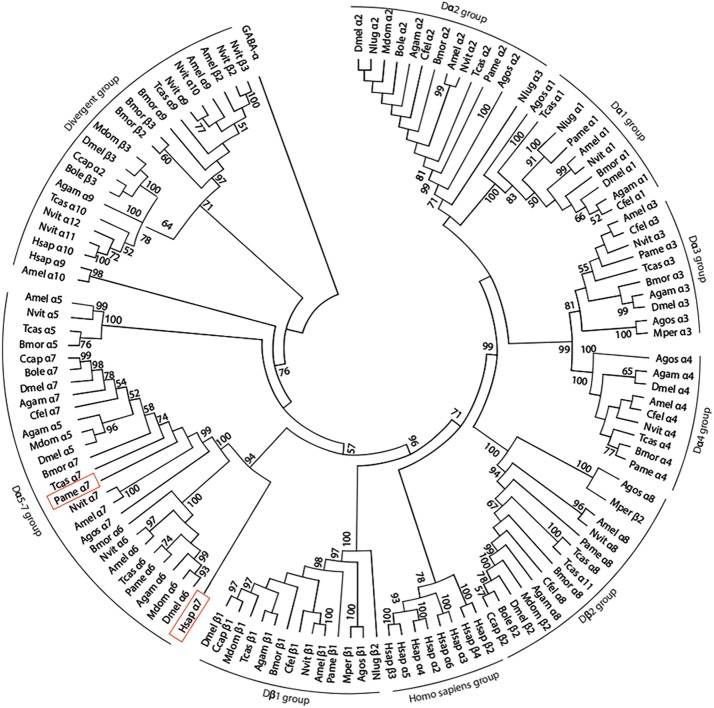
Phylogenetic tree showing relationships of alpha 7 nAChR subunit protein sequence of the cockroach P. americana and its orthologs in several insect species and human. The bootstrap support value (%) based on 1,000 replicates are shown when higher than 50%. The D. melanogaster GABAA subunit (accession number AAA28556.1) was used as outgroup. Accession sequence identifiers are as follows: Anopheles gambiae: Agamα1 (AAU12503.1), Agamα2 (AAU12504.1), Agamα3 (XP_310786.3), Agamα4 (XP_566274.3), Agamα5 (XP_314691.2), Agamα6 (XP_308042.3), Agamα7 (XP_309153.3), Agamα8 (XP_311925.3), Agamα9 (XP_310203.3), Agamβ1 (XP_309158.3); Aphis gossypii: Agosα1 (AAM94383.1), Agosα2 (AAM94382.1), Agosα3 (ABR21379.1), Agosα4 (ABR21380.1), Agosα7 (AFM78640.1), Agosα8 (BBA21164.1), Agosβ1 (AAM94384.1); Apis mellifera: Amelα1 (NP_001091690.1), Amelα2 (NP_001011625.1), Amelα3 (NP_001073029.1), Amelα4 (NP_001091691.1), Amelα5 (AJE70263.1), Amelα6 (NP_001073564.1), Amelα7 (AJE70265.1), Amelα8 (NP_001011575.1), Amelα9 (NP_001091694.1), Amelα10 (XP_392070.3), Amelβ1 (NP_001073028.1), Amelβ2 (NP_001091699.1); Bactrocera oleae: Boleα2 (XP_014100082.1), Boleα7 (XP_014102300.1), Boleβ2 (XP_0111204502.1), Boleβ3 (XP_014090987.1); Bombyx mori: Bmorα1 (ABV45511.1), Bmorα2 (ABV45512.1), Bmorα3 (ABV45513.1), Bmorα4 (ABV45514.1), Bmorα5 (ABV45516.1), Bmorα6 (NP_001091830.1), Bmorα7 (ABV45520.2), Bmorα8 (ABV45521.1), Bmorα9 (ABV45523.1), Bmorβ1 (NP_001166819.1), Bmorβ2 (NP_001103400.1), Bmorβ3 (NP_00110341.1); Ceratitis capitata: Ccapα2 (XP_004536261.1), Ccapα7 (JAB87466.1), Ccapβ1 (XP_012156453.1), Ccapβ2 (XP_012162675.1); Drosophila melanogaster: Dmelα1 (CAA30172.1), Dmelα2 (NP_524482.1), Dmelα3 (CAA75688.1), Dmelα4 (CAB77445.1), Dmelα5 (AAM13390.1), Dmelα6 (NP_723494.2), Dmelα7 (CAD86936.1), Dmelβ1 (P04755.1), Dmelβ2 (CAA39211.1), Dmelβ3 (NP_525098.1); Musca domestica: Mdomα2 (ABD37617.1), Mdomα5 (ABY40460.1), Mdomα6 (ABJ09669.1), Mdomβ1 (XP_005180169.1), Mdomβ2 (XP_005185796.1), Mdomβ3 (ABY40465.1); Myzus persicae: Mperα3 (CAB52297.1), Mperβ1 (XP_022165274.1), Mperβ2 (XP_022167599.1); Nasonia vitripennis: Nvitα1 (ACY82683.1), Nvitα2 (ACY82684.1), Nvitα3 (ACY82685.1), Nvitα4 (ACY82686.1), Nvitα5 (ACY82688.1), Nvitα6 (ACY82689.1), Nvitα7 (ACY82692.1), Nvitα8 (ACY82693.1), Nvitα9 (ACY82694.1), Nvitα10 (ACY82695.1), Nvitα11 (ACY82696.1), Nvitα12 (ACY82697.1), Nvitβ1 (ACY82698.1), Nvitβ2 (ACY82699.1), Nvitβ3 (ACY82700.1); Nilaparvata lugens; Nlugα1 (AAQ75737.1), Nlugα2 (AAQ7574101), Nlugα3 (AAQ75739.1), Nlugβ2 (AAQ75742.2); Periplaneta americana: Pameα1 (AKV94620.1), Pameα2 (AKV94621.1), Pameα3 (AKR16132.1), Pameα4 (AFA28129.1), Pameα6 (AKV94622.1), Pameα7 (MK790056), Pameα8 (AFA28130.1), Pameβ1 (AKV94624.1); Tribolium castaneum: Tcasα1 (ABS86902.1), Tcasα2 (ABS86903.1), Tcasα3 (ABS86904.1), Tcasα4 (ABS86905.1), Tcasα5 (ABS86907.1), Tcasα6 (ABS86908.1), Tcasα7 (ABS86911.1), Tcasα8 (ABS86912.1), Tcasα9 (ABS86913.1), Tcasα10 (ABS86914.1), Tcasα11 (ABS86915.1), Tcasβ1 (ABS86916.1); Homo sapiens: Hsapα2 (AAB40109.1), Hsapα3 (AAA59942.1), Hsapα4 (AAA64743.1), Hsapα5 (AAA58357.1), Hsapα6 (AAB40113.1), Hsapα7 (CAA49778.1), Hsapα9 (CAB65091.1), Hsapα10 (CAC20435.1), Hsapβ2 (CAA37320.1), Hsapβ3 (CAA47851.1), Hsapβ4 (CAA48336.1); Ctenocephalides felis: Cfelα1 (ABB42999), Cfelα2 (ABB43000), Cfelα3 (ABB43001), Cfelα4 (ABB43003), Cfelα7 (ABB43004), Cfelα8 (ABB43002), Cfelβ1 (ABB43005).